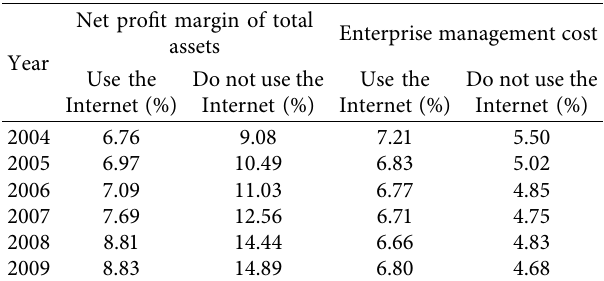
Table 4: Statistics of enterprise financial indicators from 2004 to 2009.